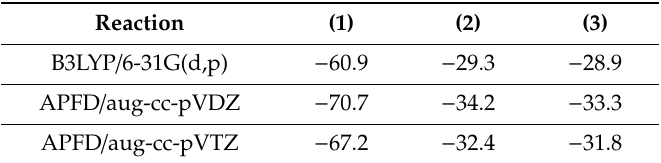
Table 6. Computed enthalpies of reaction (kcal / mol; 1.000 kcal = 4.184 kJ) for hydrogenation reactions (1)–(3) of N -methylpyrrole N -oxide and its reduction